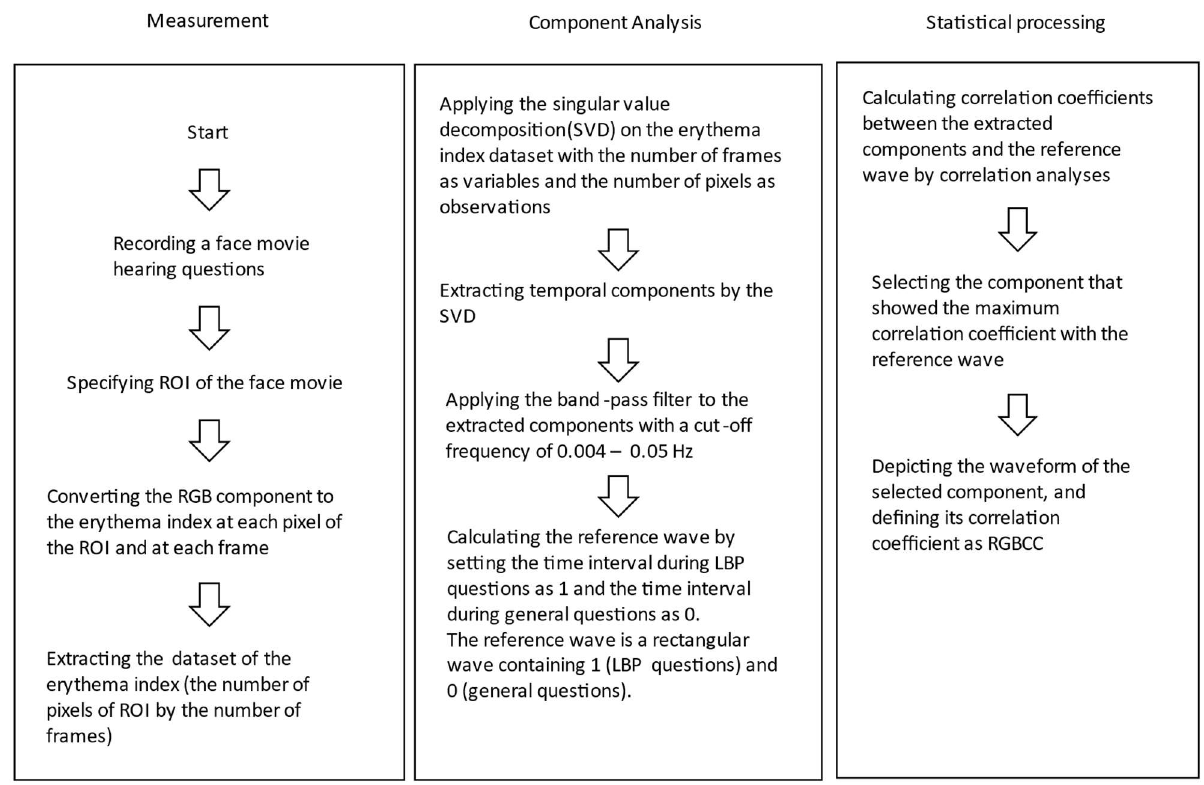
Figure 3. Data processing flow chart for calculating the facial erythema index. MATLAB, which is a multi-paradigm numerical computing environment and proprietary programming language developed by MathWorks, was used. RGB, red, green, and blue; RGBCC, red, green, and blue correlation coefficient; ROI, region of interest. LBP, lower back pain.